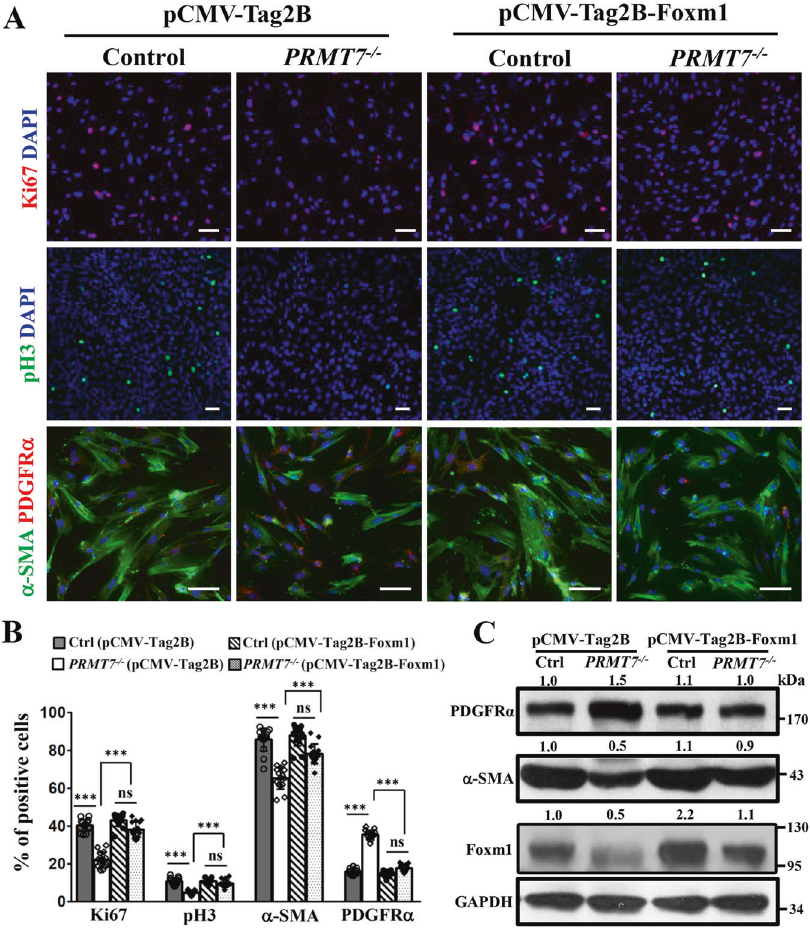
Fig. 6 Overexpression of Foxm1 rescues the proliferation and differentiation defects in PRMT7 − / − myo fi broblasts. A Representative immunostaining images for Ki67, pH3, α -SMA, and PDGFR α in control and PRMT7 − / − MYFs which were transfected with pCMV-Tag2B or pCMV- Tag2B-Foxm1. Note that both proliferation and differentiation were signi fi cantly rescued by Foxm1 overexpression in PRMT7 -de fi cient MYFs. Scale bars: 20 μ m. B Quanti fi cation of the number of Ki67 + , pH3 + , α -SMA + , and PDGFR α + cells. Data were presented as mean ± SD. n = 15 fi elds from six biological replicates of three independent experiments. ns not signi fi cant, *** P < 0.001 (one-way ANOVA with Tukey ’ s test). C Western blots analysis showing elevated α -SMA and decreased PDGFR α expression after Foxm1 overexpression in cultured PRMT7 − / − MYFs. The relative protein expression levels are listed above. GAPDH was used as a loading control. The experiment was repeated three times with similar